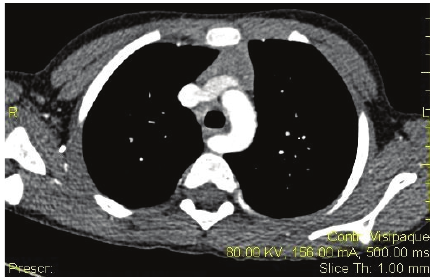
Figure 1: Angio-computed tomography : demonstrating the aberrant right subclavian artery compressing the